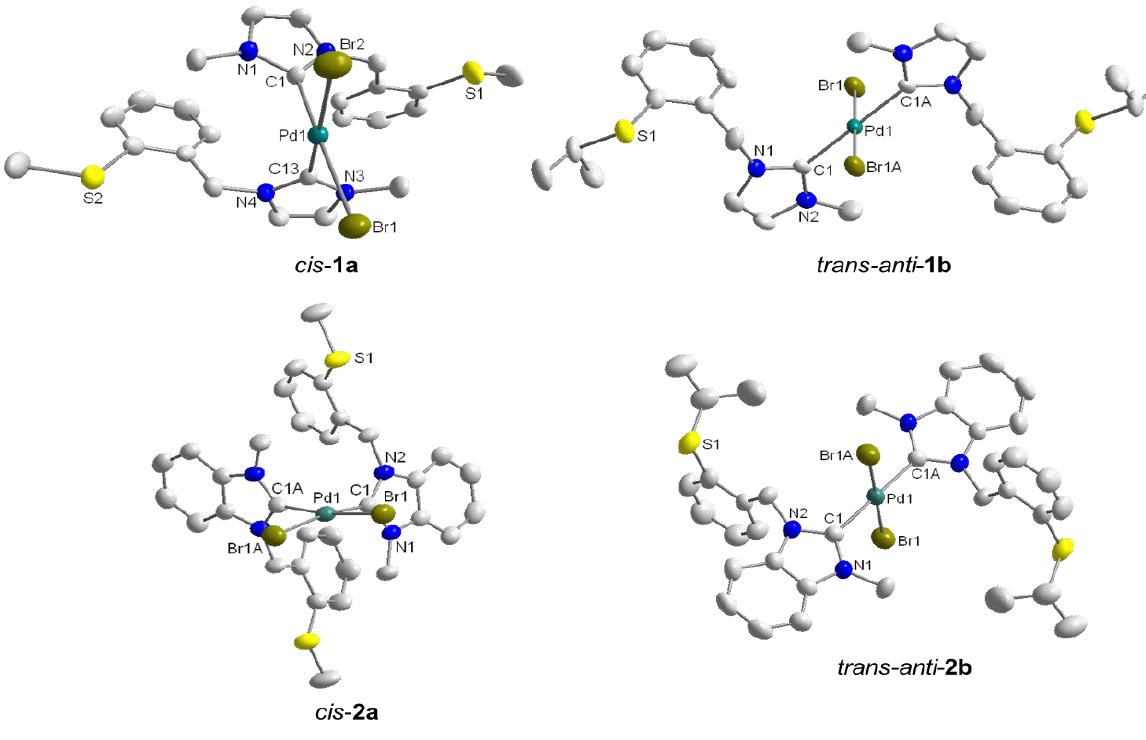
Figure 2. Molecular structures of cis - 1a , trans - anti - 1b , cis - 2a and trans - anti - 2b